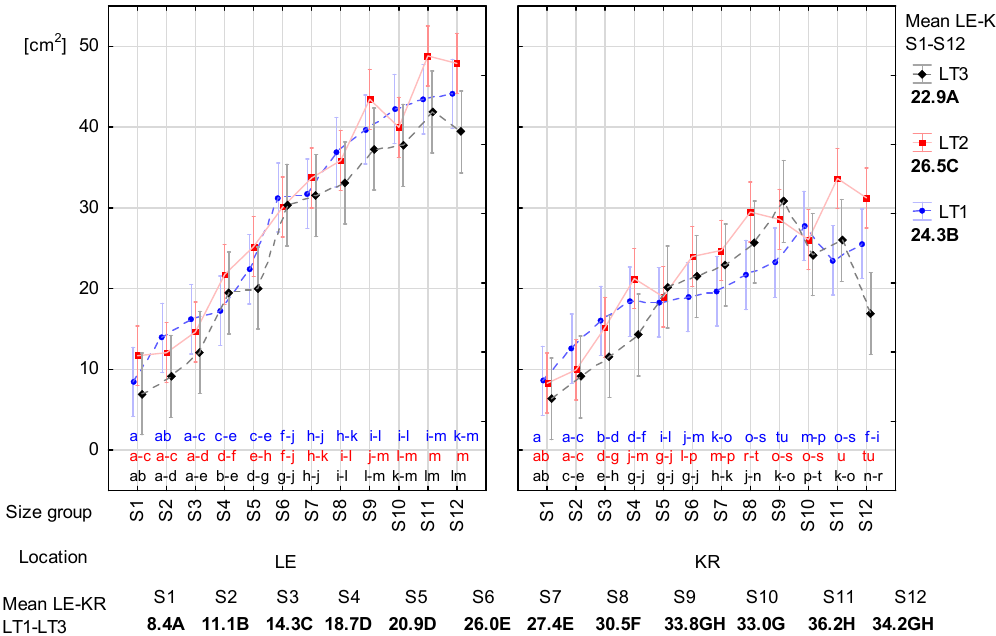
Figure 8. Effect of size group and lifting term on leaf TA (cm 2 ) for Lednice (LE) and Krakow (KR) location. Mean values with different small letter within the locations (LE or KR) as well as mean values with different large letter are significantly different according to Duncan’s multiple range test at p ≤ 0.05. For treatments description, see 2.1.–2.4, Materials and methods sections.